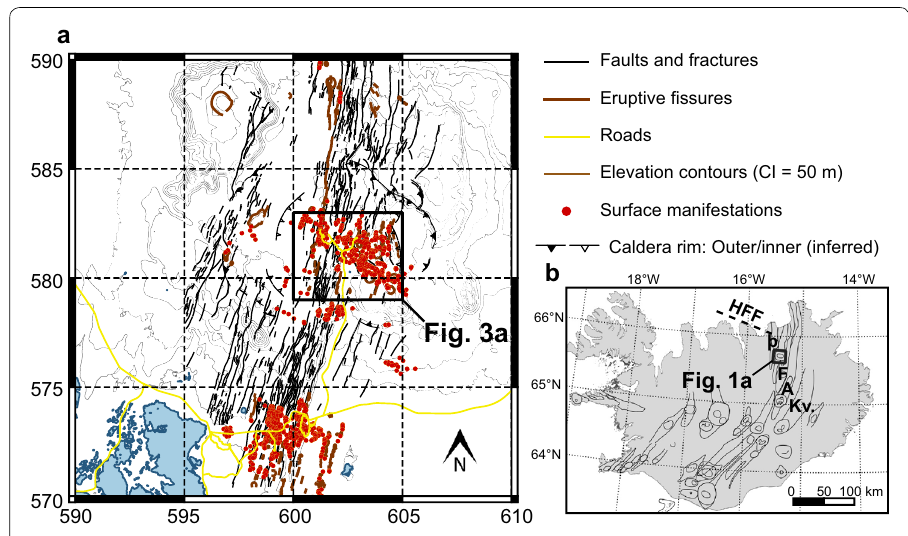
Fig. 1 Map of the Krafla area. a Topographic map of the Krafla area showing geothermal surface manifestations (red), eruptive fissures and craters (brown), outer caldera rim (lines with filled triangles), inferred inner caldera rim (lines with open triangles), and roads (yellow). Box shows the area of the geologic model built in this study (Fig. 3). b Location of the Krafla volcanic center in the northern volcanic zone, along with other volcanic centers. Volcanic centers in the Northern Volcanic Zone (NVZ) are labeled (Þ Theistareykir, F Fremrinámur, A Askja, Kv Kverkfjöll) as well as the Husavík Flatey Fault (HFF). Box shows = = = the area of the map of Krafla shown in a . Coordinates are shown in ISNET95 (same as Lambert